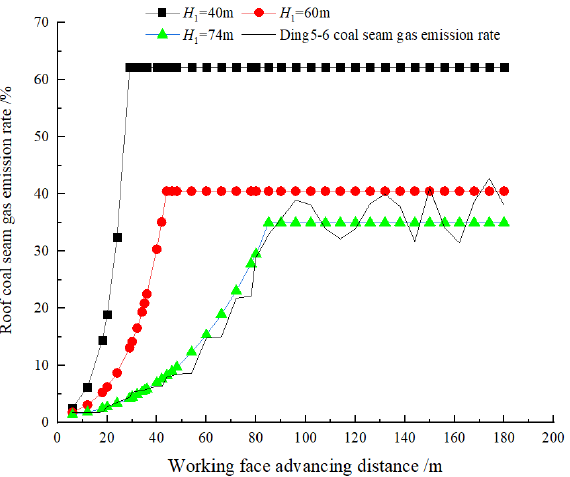
Figure 11. Variation of the gas emission rate of lower adjacent coal seams with the advancing distance of the working face.